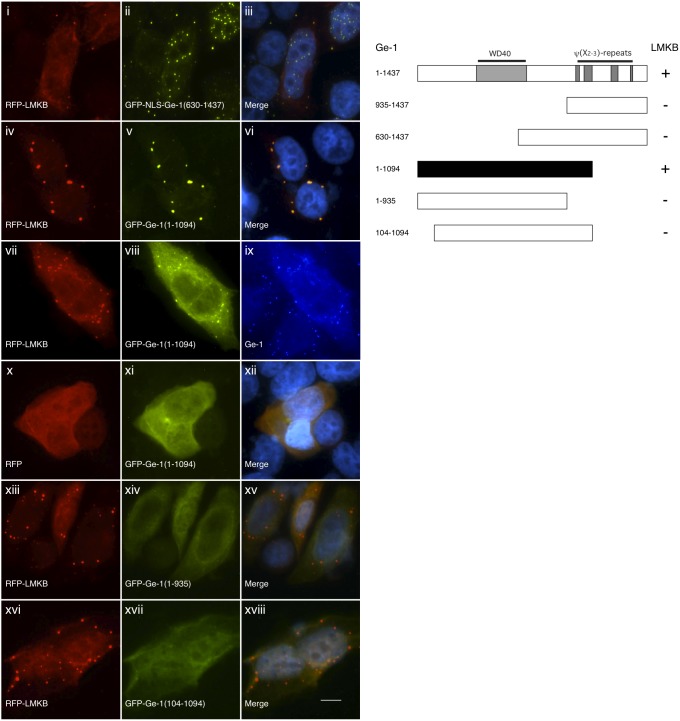
A. Delineation of the smallest portion of Ge-1 that mediates interaction with LMKB.GFP-NLS-Ge-1 fragment (amino acids 630–1437) localized to nuclear dots (green, ii) in HEp-2 cells, but RFP-LMKB remained in P-bodies and was not detected in the nucleus (red, i), suggesting that N-terminal amino acids in Ge-1 are required for interaction with LMKB. To identify the N-terminal portion of Ge-1 that interacts with LMKB, RFP-LMKB was tested for the ability to recruit N-terminal fragments of Ge-1 to P-bodies. In the presence of RFP-LMKB (red, iv), GFP-Ge-1(1–1094) localized to cytoplasmic dots resembling P-bodies (green, v). In cells expressing RFP-LMKB (red, vii) and GFP-Ge-1(1–1094) (green, viii), both proteins co-localized with endogenous Ge-1 (blue, ix), confirming that these structures are P-bodies. In the absence of LMKB (RFP alone, red, x), GFP-Ge-1(1–1094) did not localize to P-bodies (green, xi), but was instead distributed throughout the cytoplasm. Smaller fragments of Ge-1, including amino acids 1–935 (green, xiv) and 104–1094 (green, xvii) did not co-localize with co-expressed LMKB in P-bodies. Merge of fluorescence in i and ii, iv and v, x and xi, xiii and xiv, and xvi and xvii is shown in iii, vi, xii, xv and xviii. DAPI staining (blue in the merged panels) indicates the location of nuclei. White bar in xviii indicates 5.0 µm. B. Schematic representation of Ge-1 and summary of results. The N-terminus of Ge-1 contains a WD40 repeat domain. The C-terminus contains four regions that have repeating hydrophobic residue periodicity (ψ(X2-3)-repeat domains). + indicates a fragment of Ge-1 that interacts with LMKB; - indicates a fragment of Ge-1 that does not interact with LMKB. The black rectangle indicates the smallest tested portion of Ge-1 that interacts with LMKB.